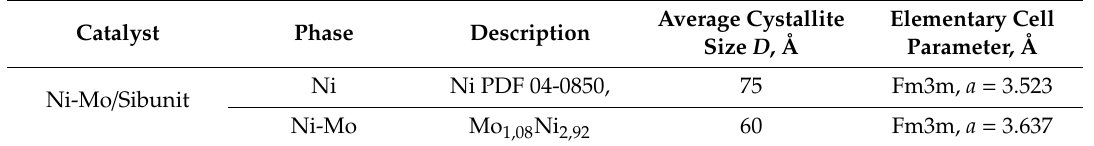
Table 2. Diffraction characteristics of the active component of supported Ni-Mo/Sibunit. Figure 2. XRD pattern of 8% Ni-2.5% Mo/Sibunit.